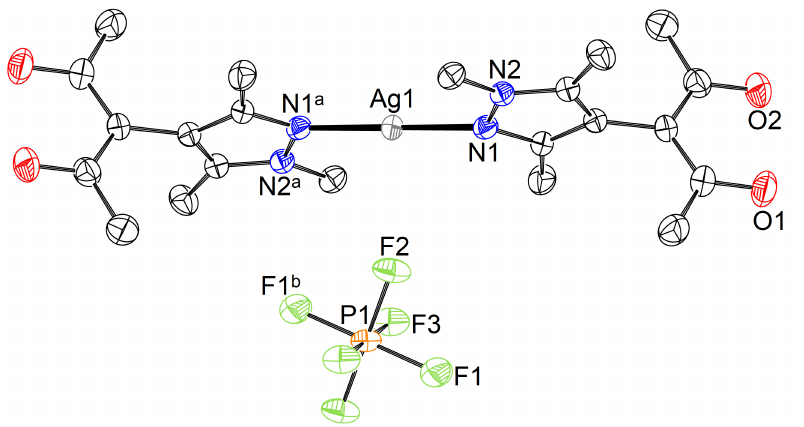
Figure 2. Displacement ellipsoid plot [33] of 1 (70% probability, hydrogen omitted). Selected distances and angles (Å, °): Ag1–N1 2.125(2), Ag1 ··· F2 2.9444(15), ω 84.84(12). Symmetry operations: a = 1 − x , − y , − z ; b = − x , − y , − z .